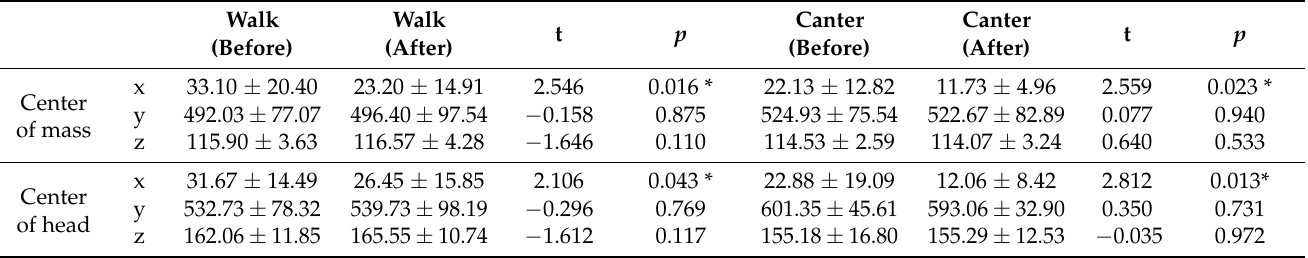
Table 2. Displacements of the center of mass and the center of the head. Unit: cm.